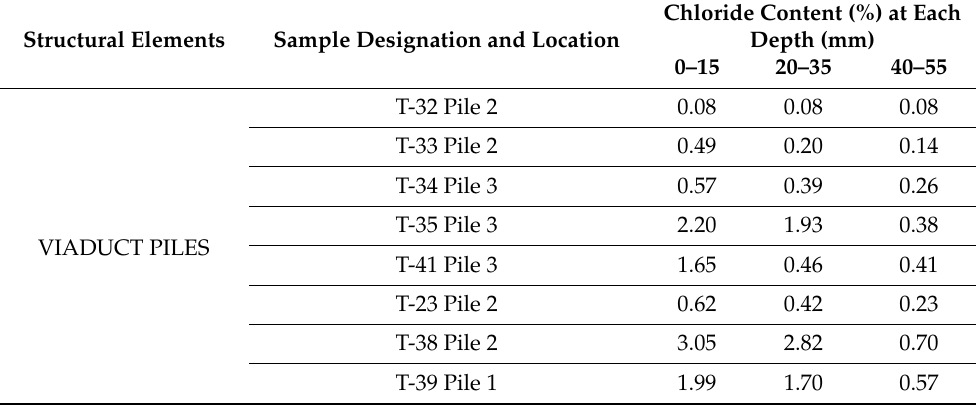
Table 2. Compilation based on chloride concentration data in the position of pile reinforcement of Viaduct 3 (% weight of cement). (Data source: Technical Institute of Materials and Constructions (INTEMAC); May